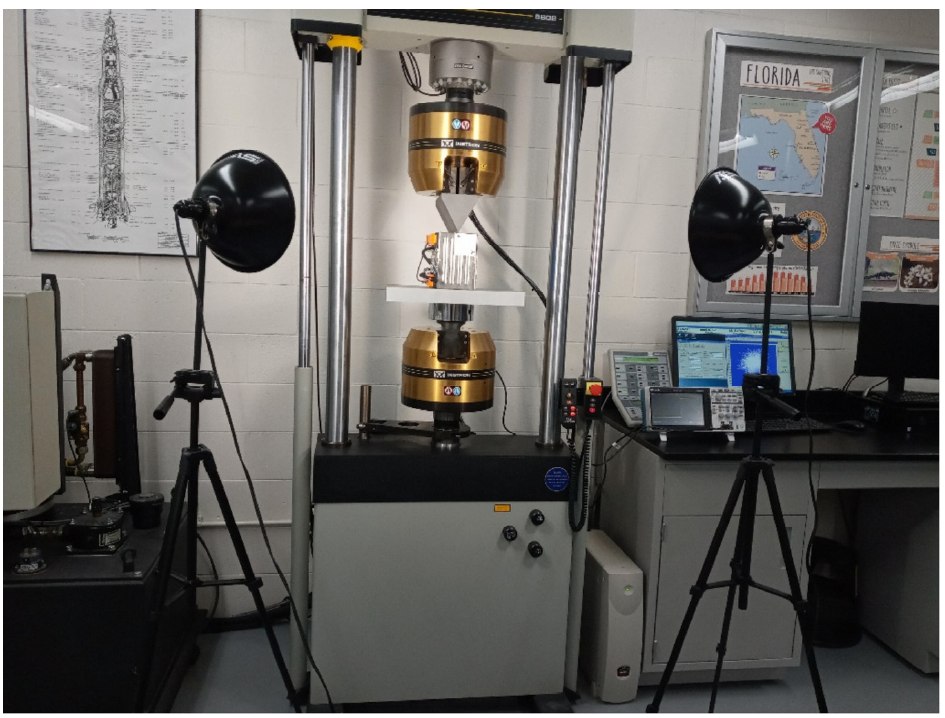
Figure 2. Experimental setup for quasi-static Li-ion battery indentation tests. The tripod mounted digital camera is situated nearby. A piezoelectric accelerometer with sensor signal conditioner was later added for the higher speed test.